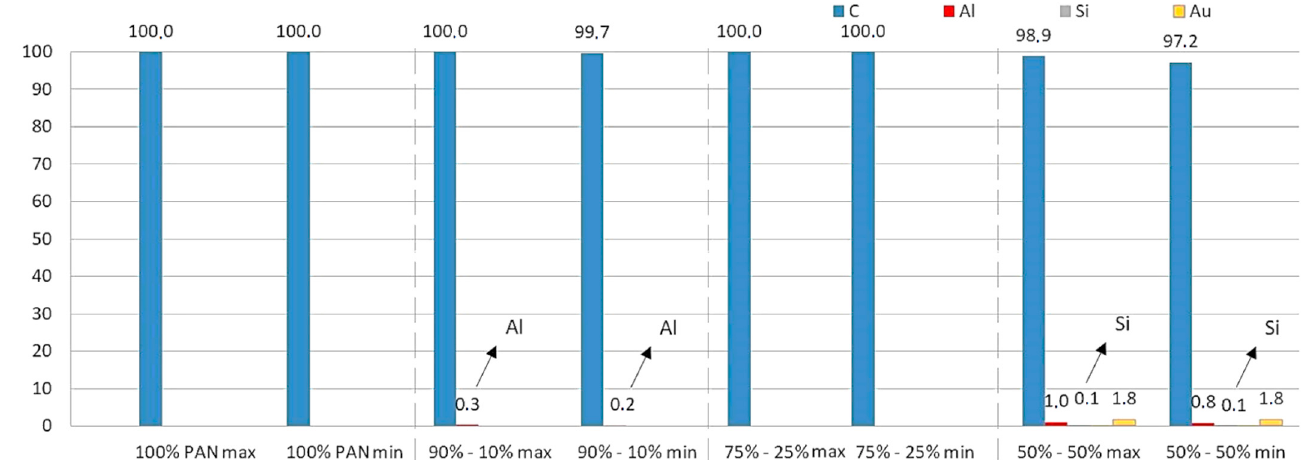
Figure 8. EDS analyses of carbonized fibers, and mass percentages of the detected elements.